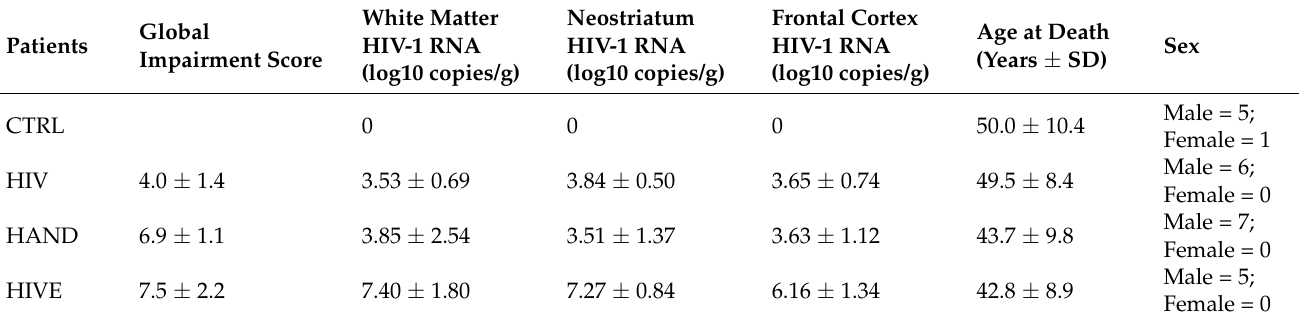
Table 1. Clinical characteristics of the patients’